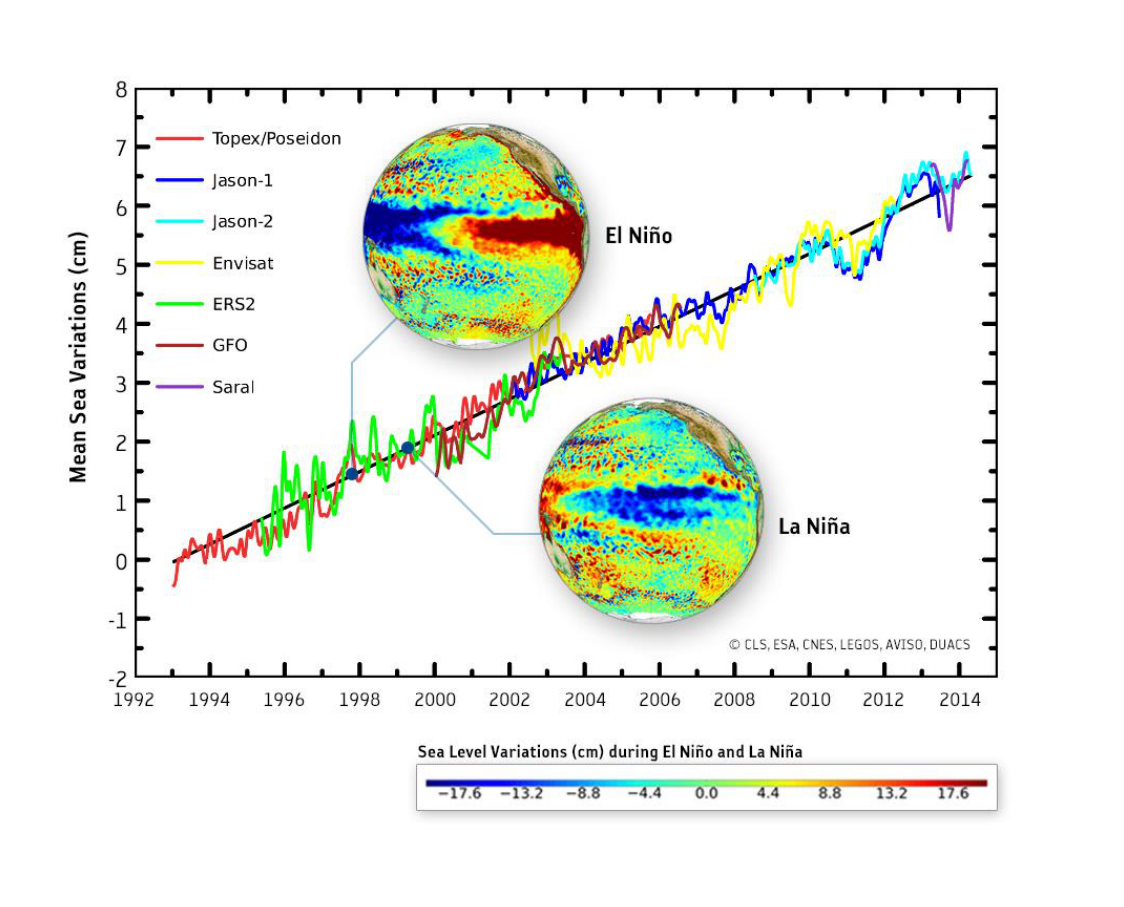
Figure 2. Global trend in mean Sea Level (in cm) as derived from a series of altimeters